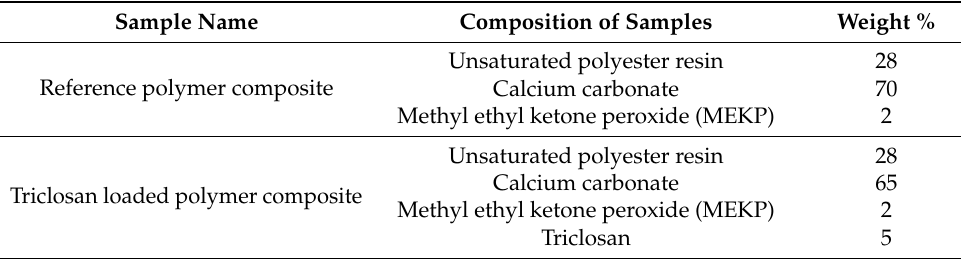
Table 2. Production of polymer composite loaded with